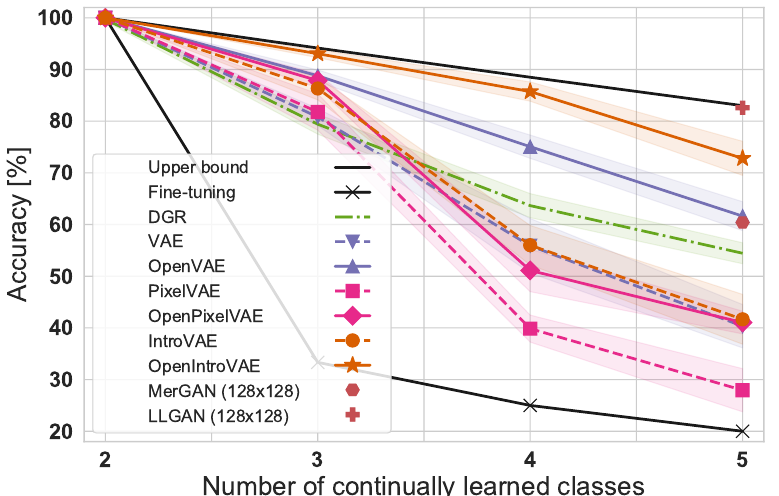
Figure 5. Classification accuracy over five runs for continually learned flowers at 256 × 256 resolu- tion to demonstrate how generative modeling advances draw similar benefits from our proposed aggregate posterior constrained generative replay (solid lines) over the open-set-unaware baselines (dashed